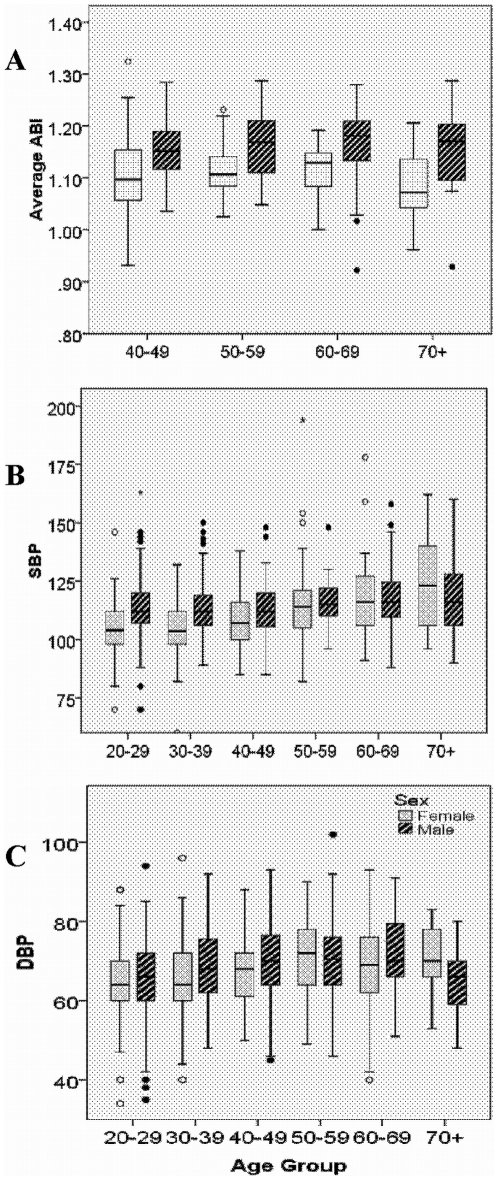
Median and interquartile values of (A) ABI (averaged across left and right sides), (B) systolic BP and (C) diastolic BP, for Tsimane by age group and sex.